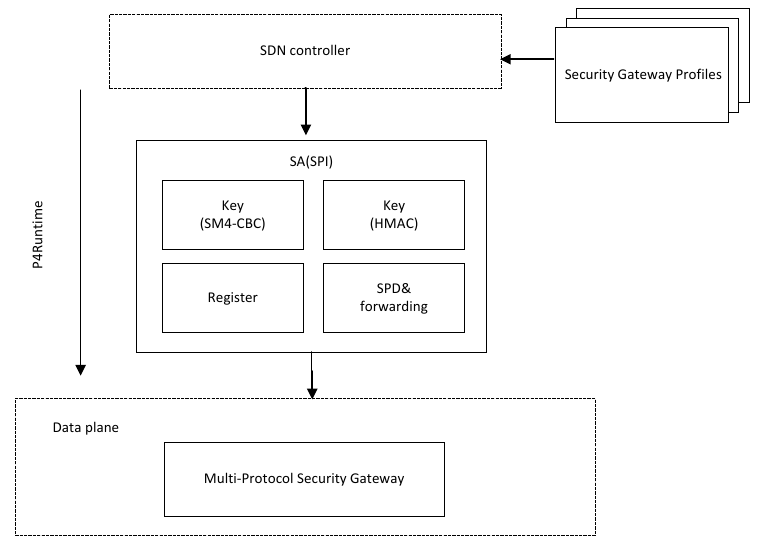
Figure 9. Application of security gateway